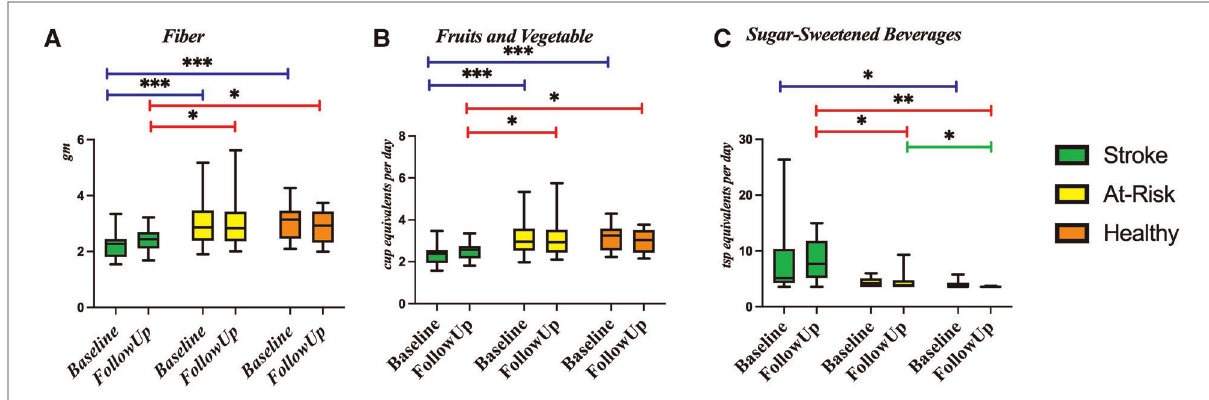
FIGURE 4 Diet composition amongst the groups. Diet was compared between each of the groups using a Wilcoxon rank sum test in several components: ( A ) fi ber, ( B ) fruit and vegetables, and ( C ) sugar-sweetened beverages. * p -value<0.05; ** p -value<0.01; *** p -value<0.001.